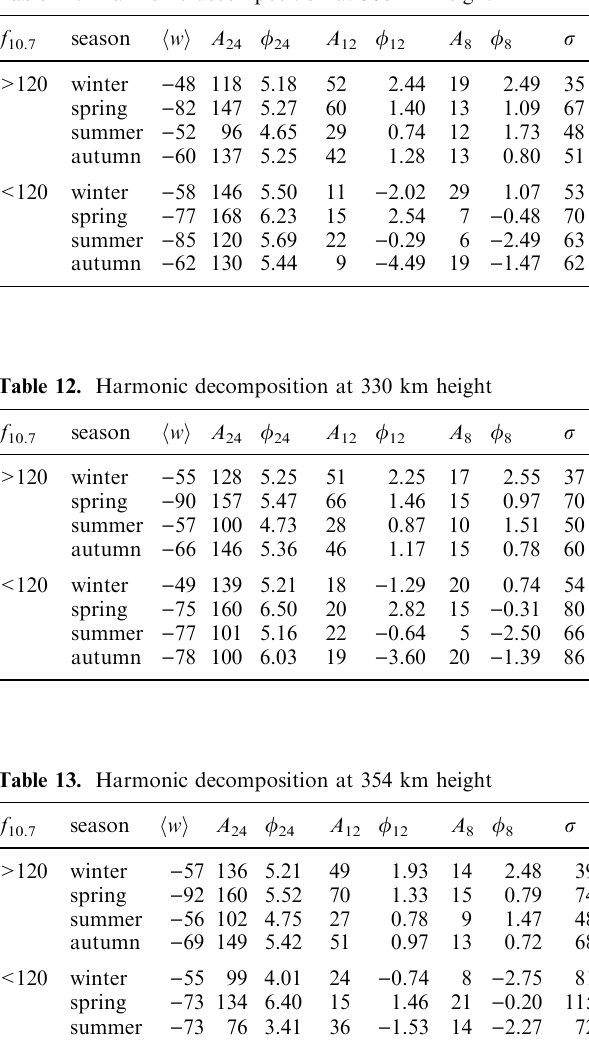
Table 8. Harmonic decomposition at 233 km height Table 11. Harmonic decomposition at 306 km height